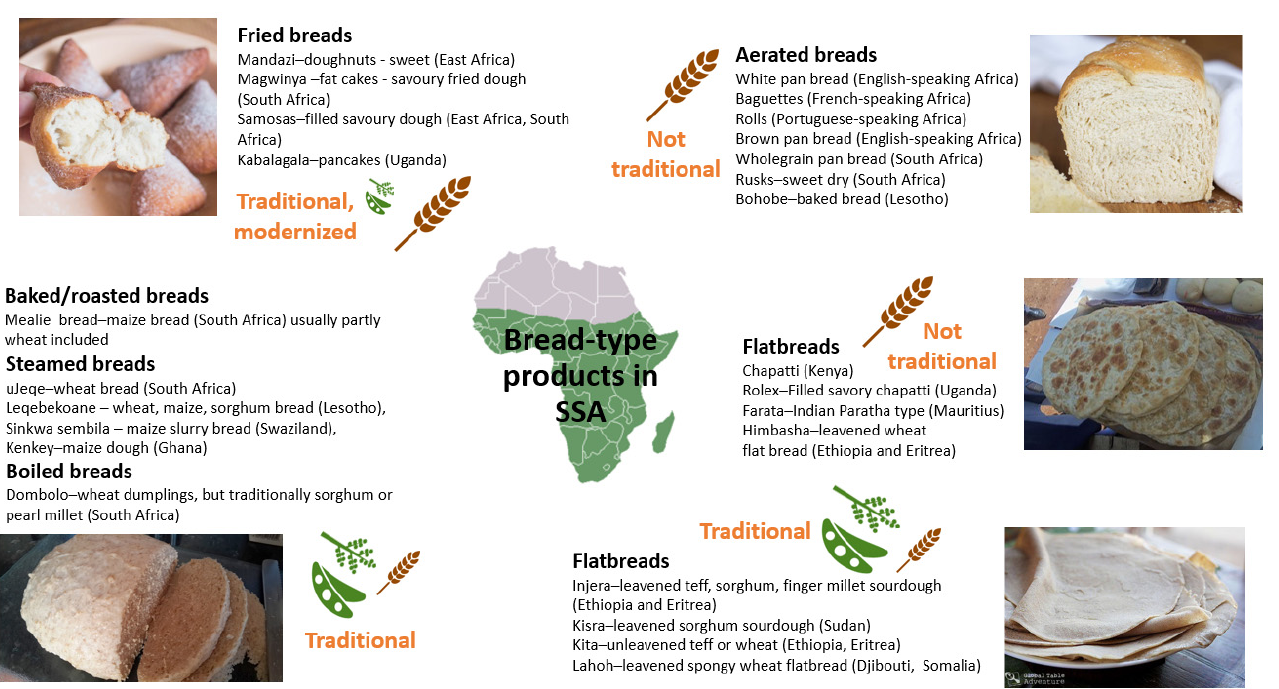
Figure 3. Bread and bread-type products in SSA. Overview of the main product categorization with nonextensive examples of products and the country/region of origin. For each product group, an indication is given whether or not the product can be considered traditional, and the size of the icons for wheat [ ] and CRC [ ] indicate ingredient use.